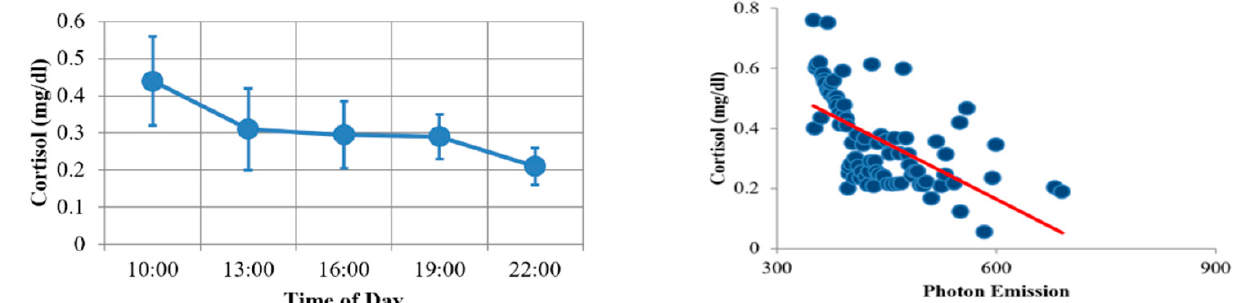
Figure 9. Correlation between cortisol and photon levels.